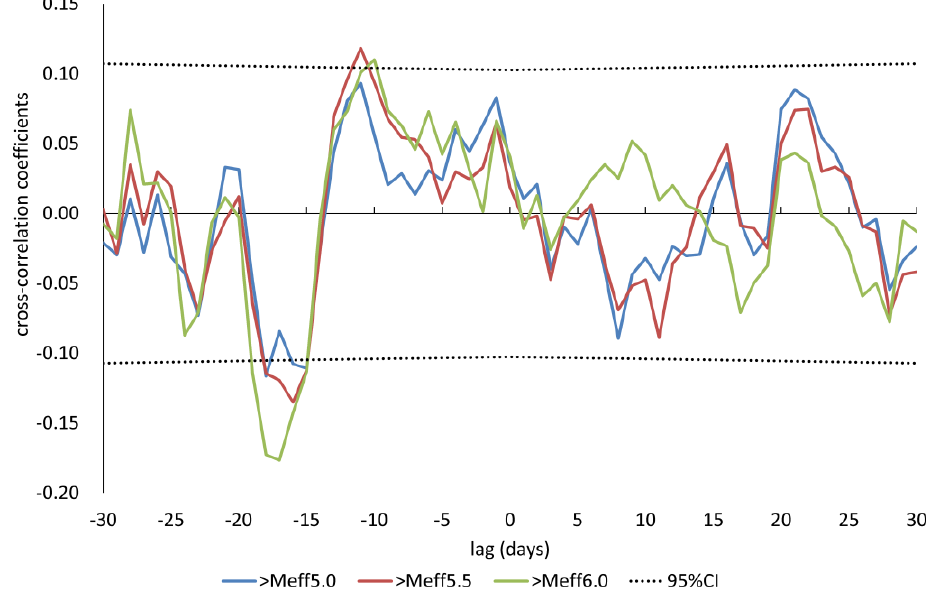
Figure 6. The results of cross-correlation analyses between milk yields and the dates exceeding each Meff; CI = confidence interval.